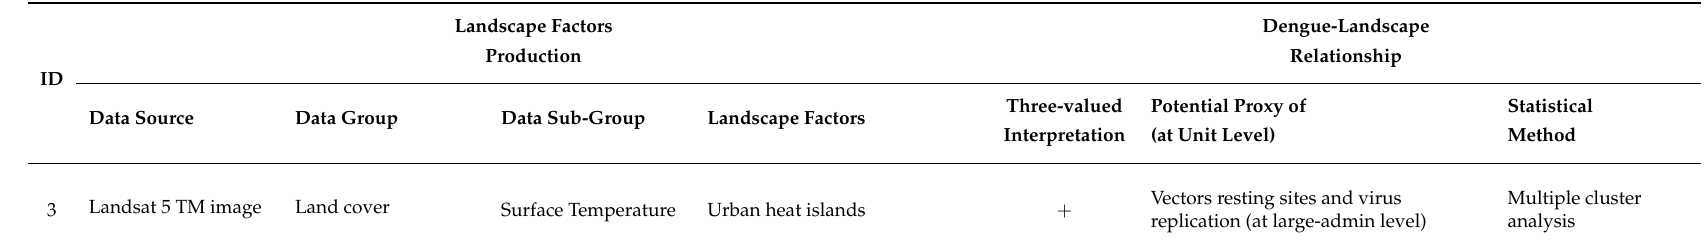
Table 3. Structuring of the data extracted from the articles on the landscape factor production and the dengue-landscape relationship. First line (id: 3) is given as an example. Please refer to the annex-table 3 for the whole dataset ([n = 78]